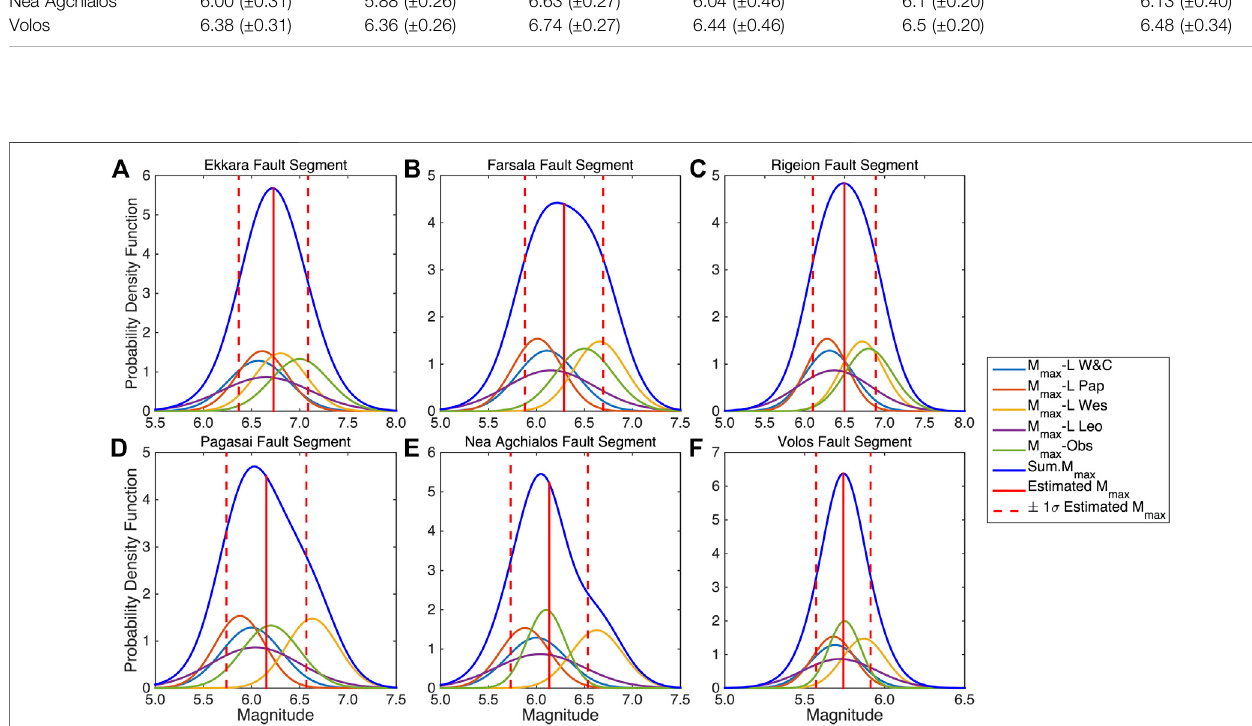
Frontiers in Earth Science |